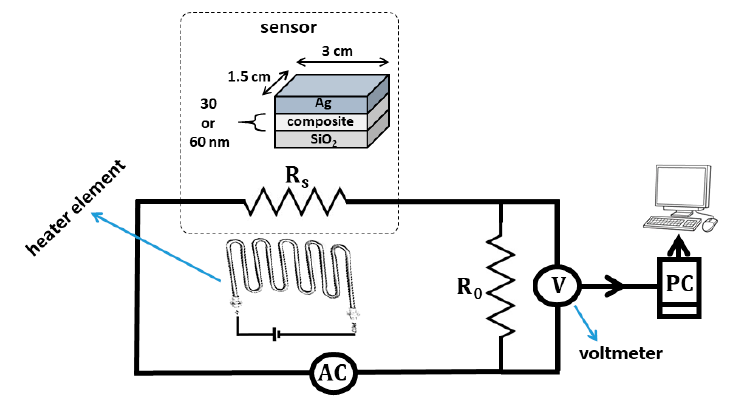
Figure 9. The schematic system for measuring the sensor